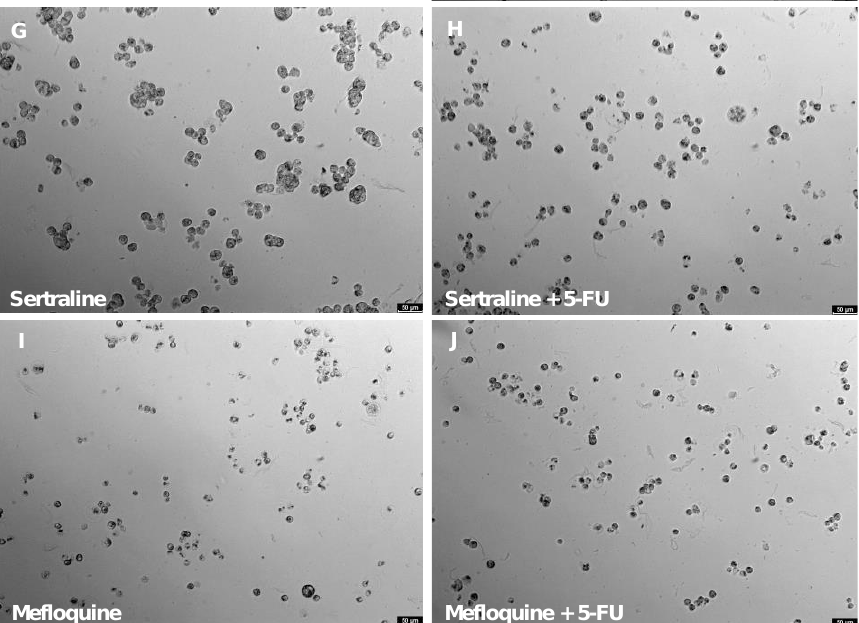
Figure 5. Microscopic cellular visualisation of HT-29 cells after 48 h of incubation with vehicle ( A ), 5-FU ( B ), latrepirdine ( C ), latrepirdine + 5-FU ( D ), thioridazine ( E ), thioridazine + 5-FU ( F ), sertraline ( G ), sertraline + 5-FU ( H ), mefloquine ( I ) and mefloquine + 5-FU ( J ) at concentrations of 4 × IC 50 of each drug.